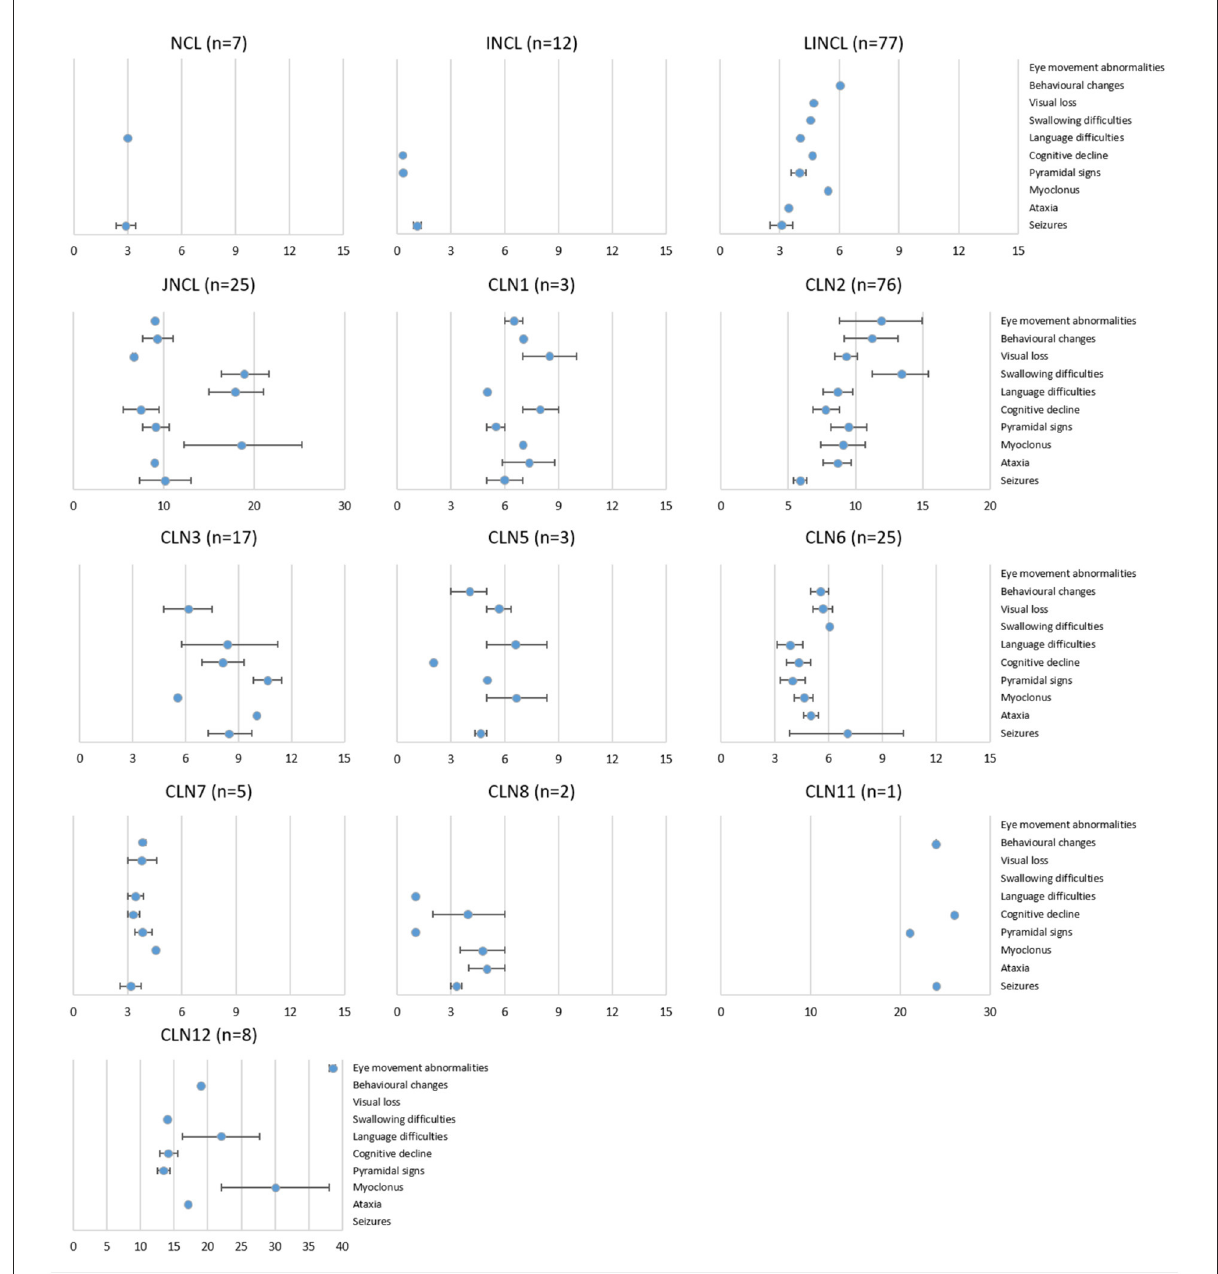
FIGURE3 Disease evolution of all NCL variants in the SA & C cohort. Graphs showing the age of onset (mean ± SEM) of some symptoms for each NCL genotype and phenotype in the SA & C cohort. Values were obtained directly from clinical records or publications or estimated from the information available in the bibliography. The set of symptoms collected was adapted from Lourenço et al. (11). The number of individuals analyzed for each NCL variant is shown next to the graph titles. Values of the X-axis are expressed in